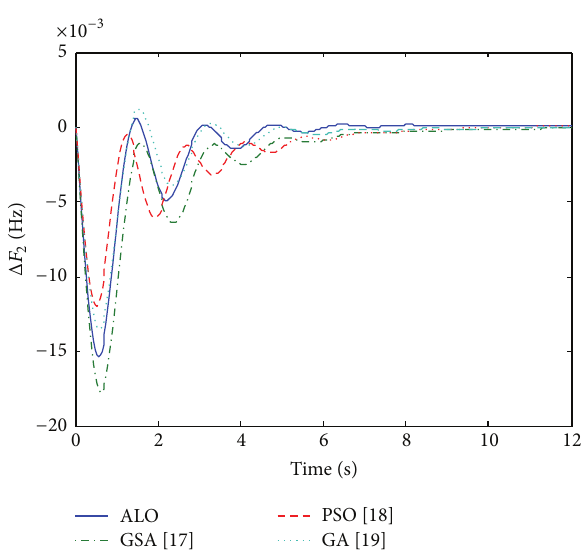
Figure 5: Change in frequency of area 2 by 10% load increase in area 1.